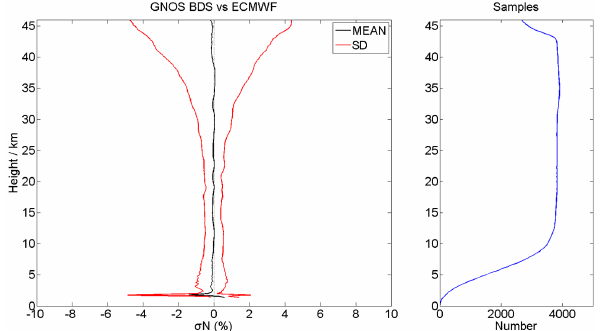
Figure 5. Same as Fig. 4, but for GNOS BDS.